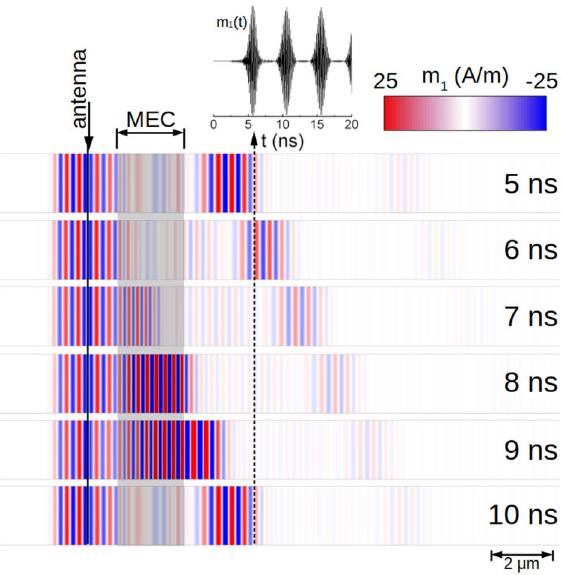
Figure 5. Magnetization component m 1 of the spin-wave AS mode at 6 GHz in Co which passes MEC for different points in time. The inset shows the time dependence of m 1 at the fixed point in Co film after the output of MEC.